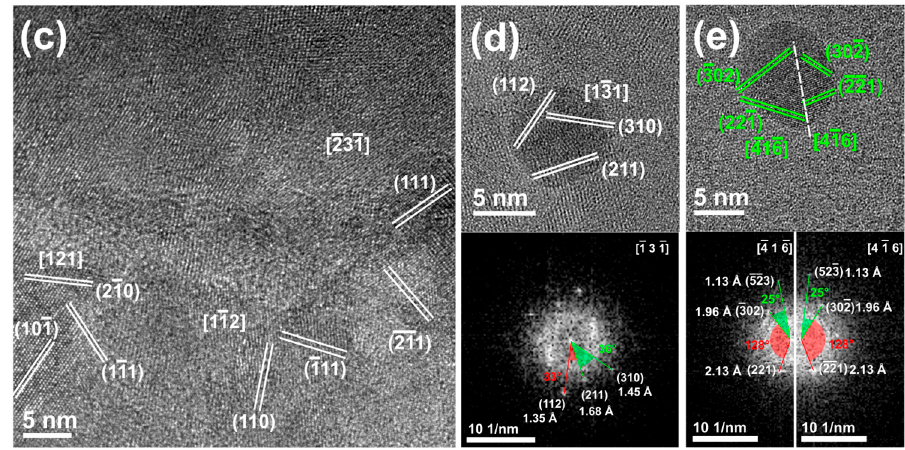
Figure 3. In situ HRTEM heating experiment of micron-sized TANs: ( a , b ) Evolution of the small aggregates of TANs reported in Figure 2, now recorded at 380 °C. The red arrows reported in panel a and b indicate the localization of several small crystalline seeds not observed in the panel ( a , b ) of Figure 2. The white dotted rectangles indicate the regions of interest analyzed by HRTEM and reported in panels c , d and e ; ( c ) HRTEM image of a region with patched crystallization of rutile (in white) in the first aggregate (see the rectangle in panel 3 a ); ( d ) HRTEM image of a rutile seed (in white) in the second aggregate (see the rectangle on the left in panel and corresponding two-dimensional fast Fourier transform (2D-FFT) showing the expected interplanar distances and angular relationships, 3 b ); ( e ) HRTEM image of a polycrystalline brookite seed (in green) in the second aggregate (see the rectangle on the right in panel 3 b ). The two main crystalline domains are separated by a white dashed line, and the corresponding 2D-FFTs are presented below. Both show the interplanar distances and angular relationships expected from brookite.